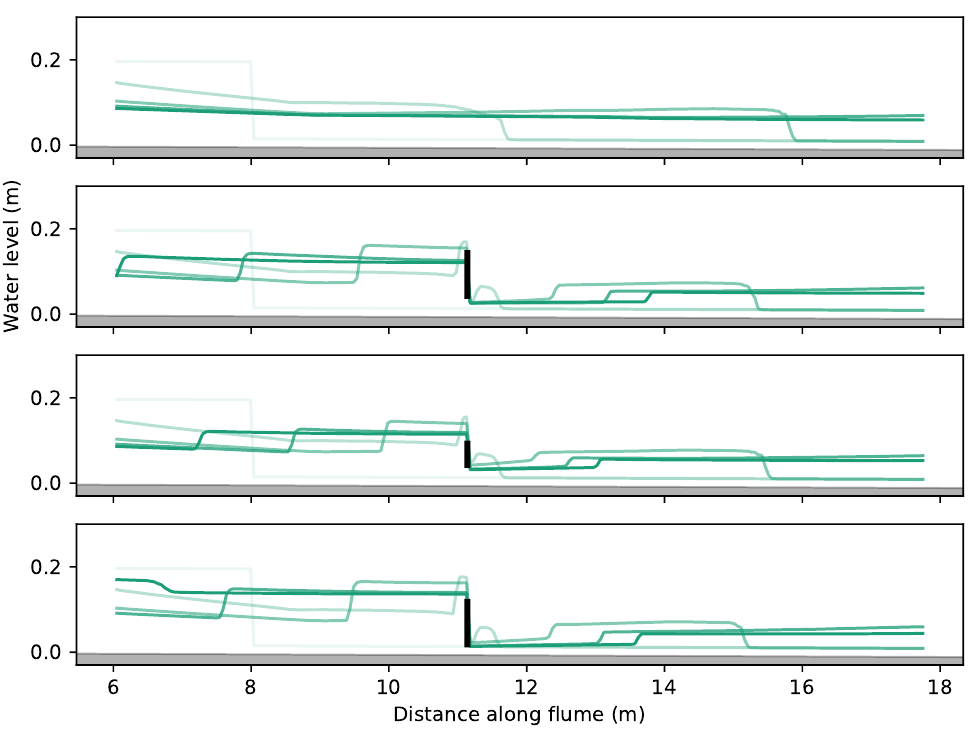
Figure 11. Longitudinal profiles at t = 0.0,1.4,2.8,4.2,5.6,7.0 s for the dam break simulations for configurations (a)–(d).